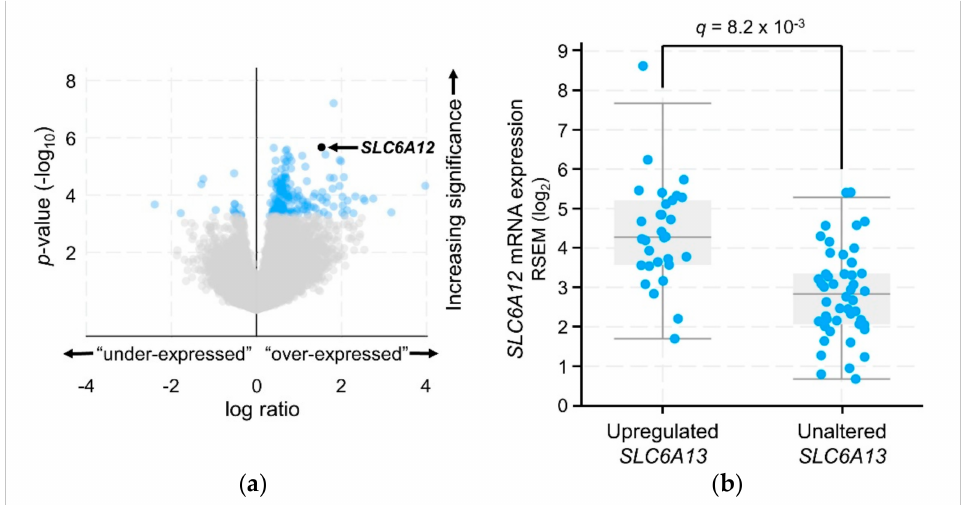
Figure 10. Genes altered in samples with upregulated SLC6A13 transcripts. ( a ) Volcano plot representing log 2 transformation of the ratio of an enriched gene’s average transcript level in the “upregulated” samples relative to that gene’s average transcript level in the “unaltered” group of samples ( x -axis = “log ratio”), as plotted against the p -value (unpaired t -test) significance of each transcript’s enrichment in the “upregulated” samples (y-axis = log 10 p -value). Light grey = q > 0.05; blue = q ≤ 0.05; (Benjamini-Hochberg correction). ( b ) SLC6A12 gene expression levels, in tumors with upregulated vs unaltered SLC6A13 transcript expression. Plots generated by cBioPortal,